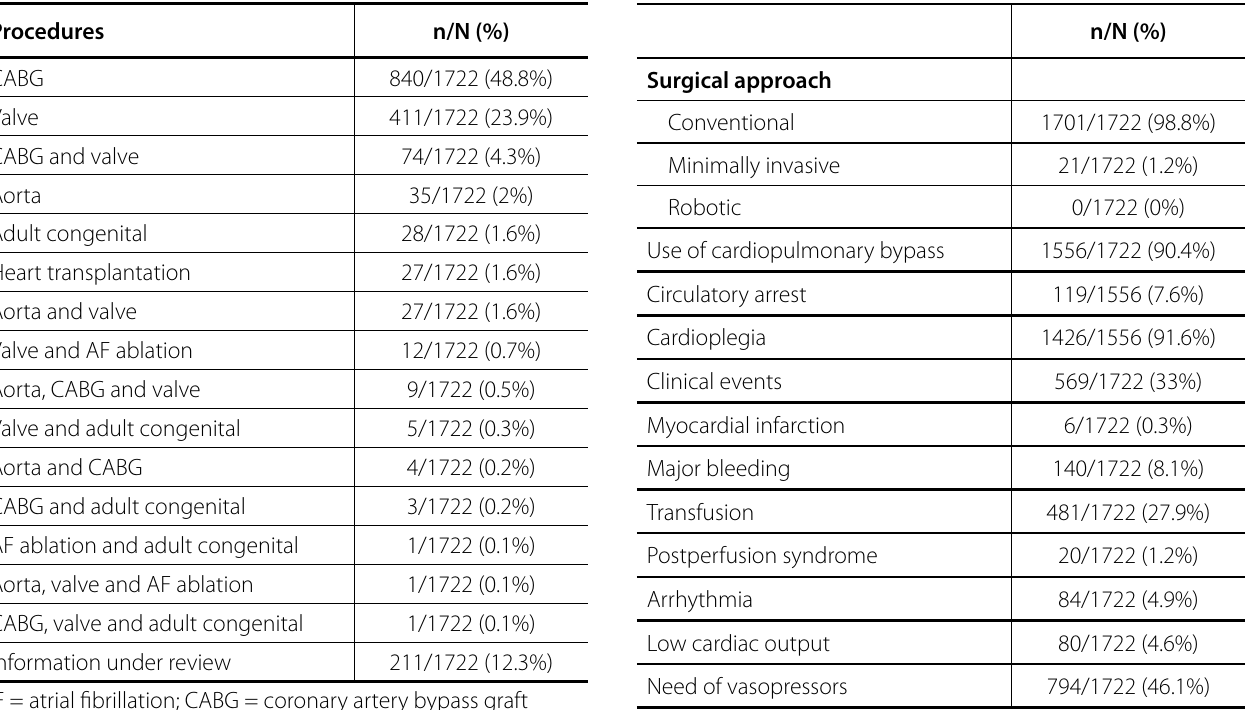
Table 4. Perioperative data and events. Table 3. The commonest types of